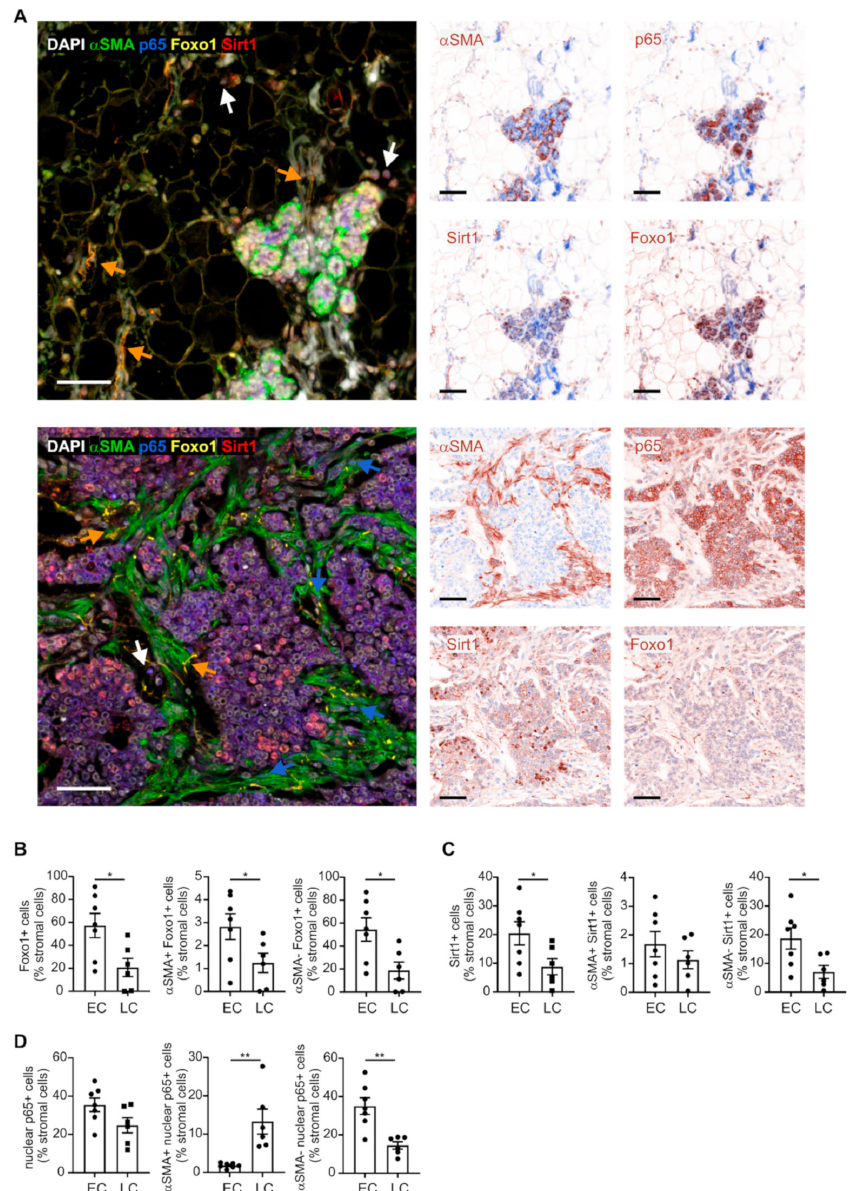
Figure 5. Histological validation of enriched gene signature in early versus late cancer-associated fibroblasts (CAFs). ( A ) Early- and late-stage PyMT tumors were harvested and analyzed for expression of nuclear p65, as well as Sirt1 and Foxo1 using PhenOptics. Nuclei were counterstained with DAPI. Representative images show combined expression of all markers as well as expression of single markers. Colored arrowheads indicate fibroblasts co-expressing Foxo1 and Sirt1 (orange) or α -SMA and nuclear p65 (blue), and nuclear p65-expressing lymphocytes (white). Scale bars: 50 µ m. ( B ) Foxo1 expression in total stroma, α SMA + stromal cells, and α SMA- stromal cells is displayed. ( C ) Sirt1 expression in total stroma, α SMA + stromal cells, and α SMA − stromal cells is displayed. ( D ) Nuclear p65 expression in total stroma, α SMA + stromal cells, and α SMA- stromal cells is displayed. Individual data points indicate mean expression of markers in tissue sections of one individual animal. Additionally, means ± SEM are shown. p -values were calculated using one-way ANOVA with Bonferroni’s correction, * p < 0.05, *** p <